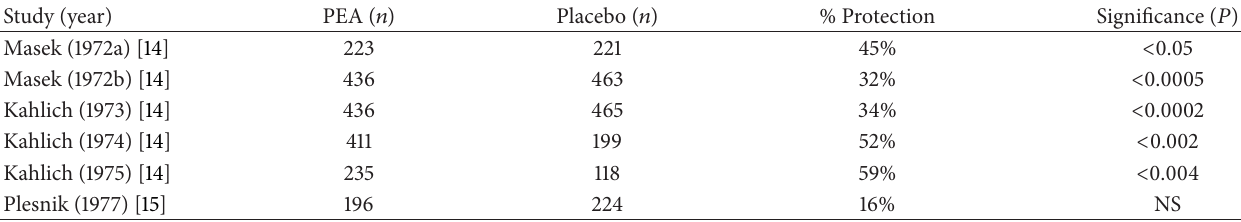
Table 1: Incidence of endpoints between both the PEA and the placebo